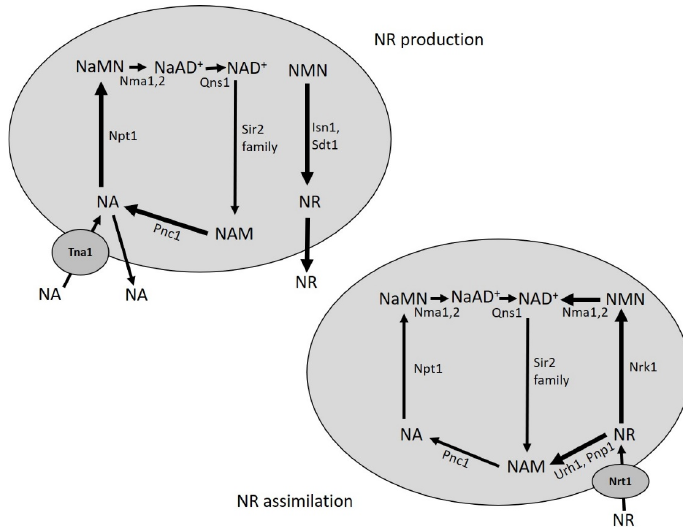
Figure 2. Simplified scheme of NA and NR metabolism in yeast. NA and NR are constitutively produced, released in the growth medium and retrieved by yeast cells. Uptake of NA and NR depends on Tna1 and Nrt1, respectively. NA fuels the Preiss-Handler pathway and NR enters the Nrk1-dependent and Urh1/Pnp1-dependent salvage routes. NA is synthesized intracellularly from NAM, while NR from NMN. Abbreviations of enzyme names are reported. See text for details.